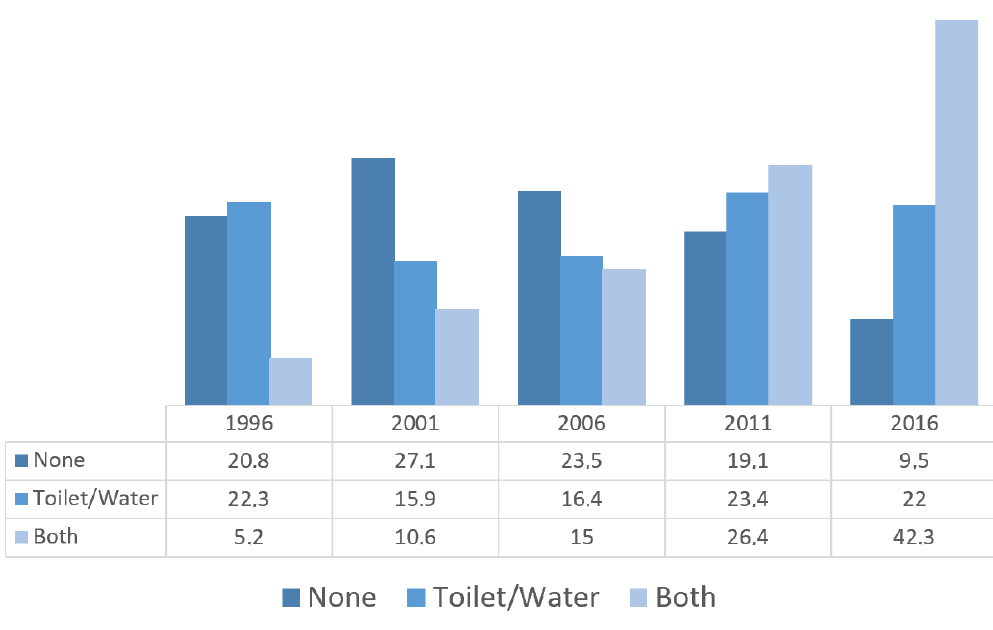
Figure 3. Progress towards coverage of improved water and sanitation access among Nepalese households 1996 – 2016.